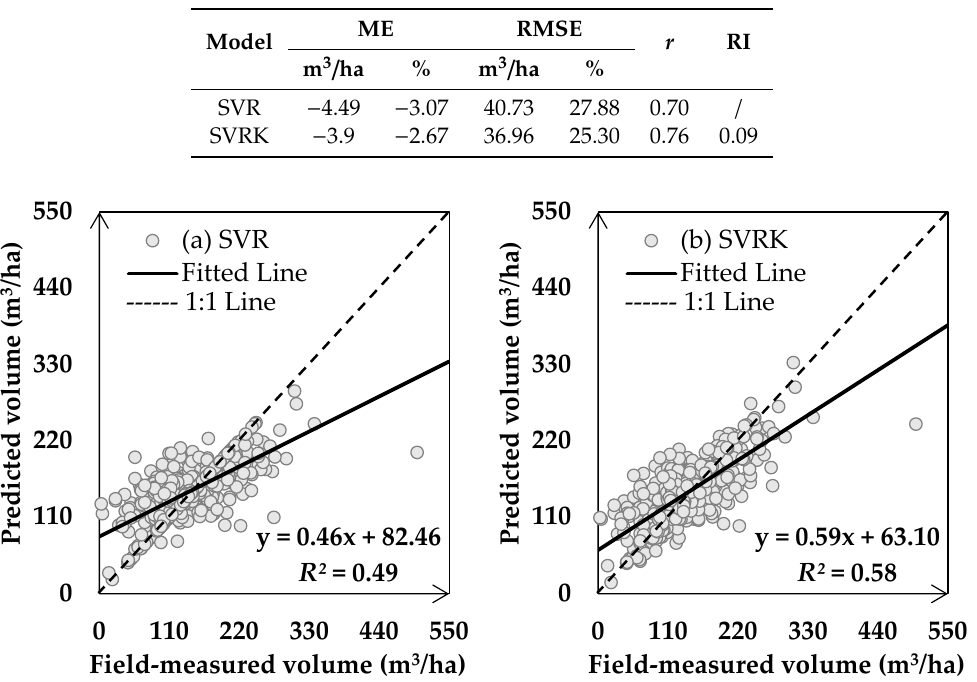
Table 4. Accuracy assessment of stand volume modeling based on independent validation data.